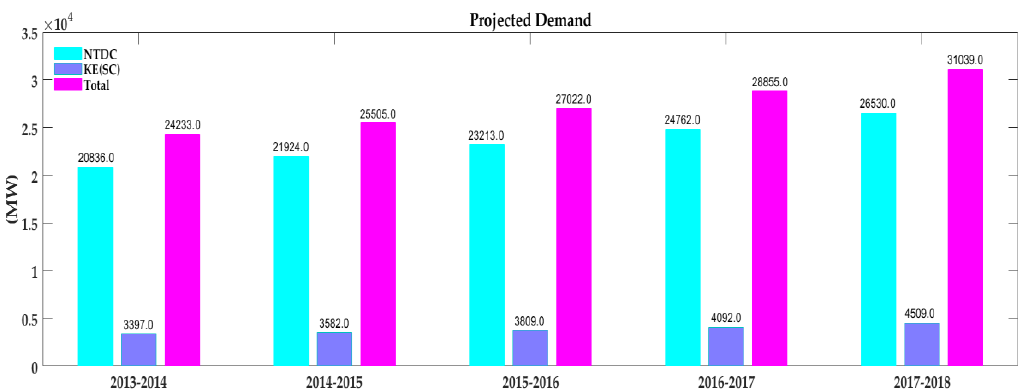
Figure 3. Yearly demand graph of NTDC and